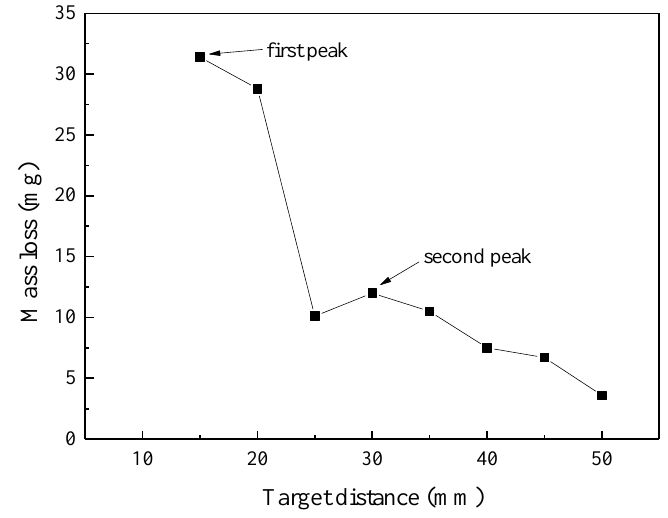
Figure 8. Mass loss of the samples under different target distances.